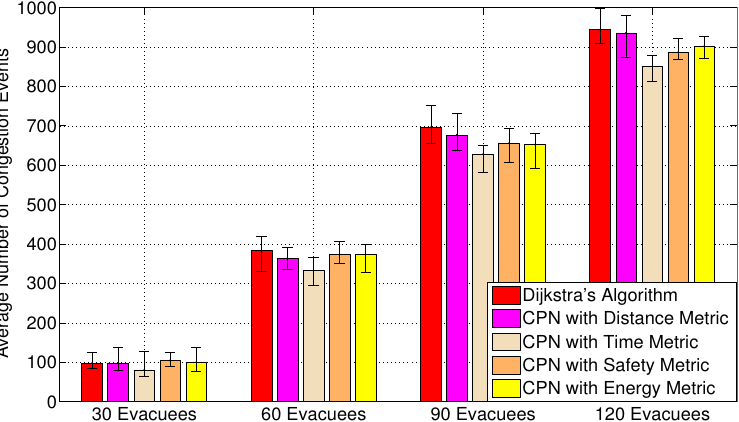
Figure 5. The average number of congestion situations appears in each scenario for different path finding algorithms. Congestion is assumed to happen when an evacuee reaches a node with a non-zero queue